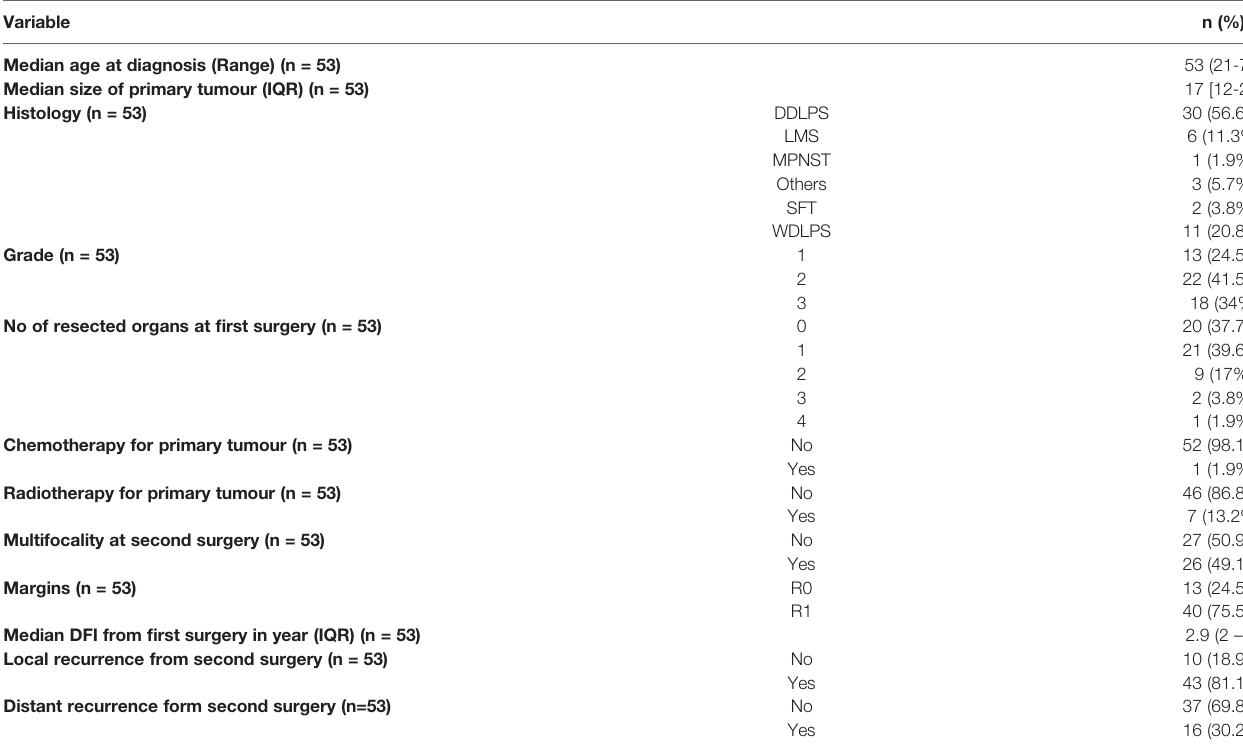
TABLE 1 | Patient and tumour characteristics.